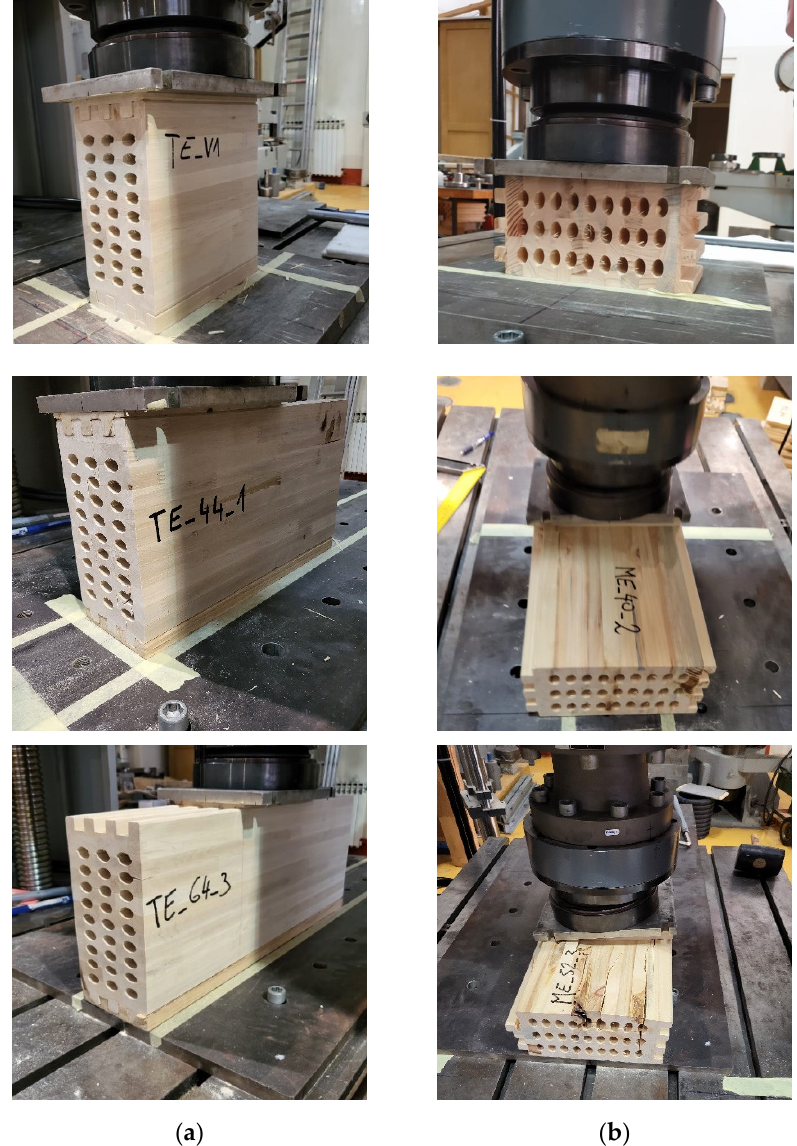
Figure 7. Loading of specimens: ( a ) in strong-axe direction; ( b ) in week-axe direction.